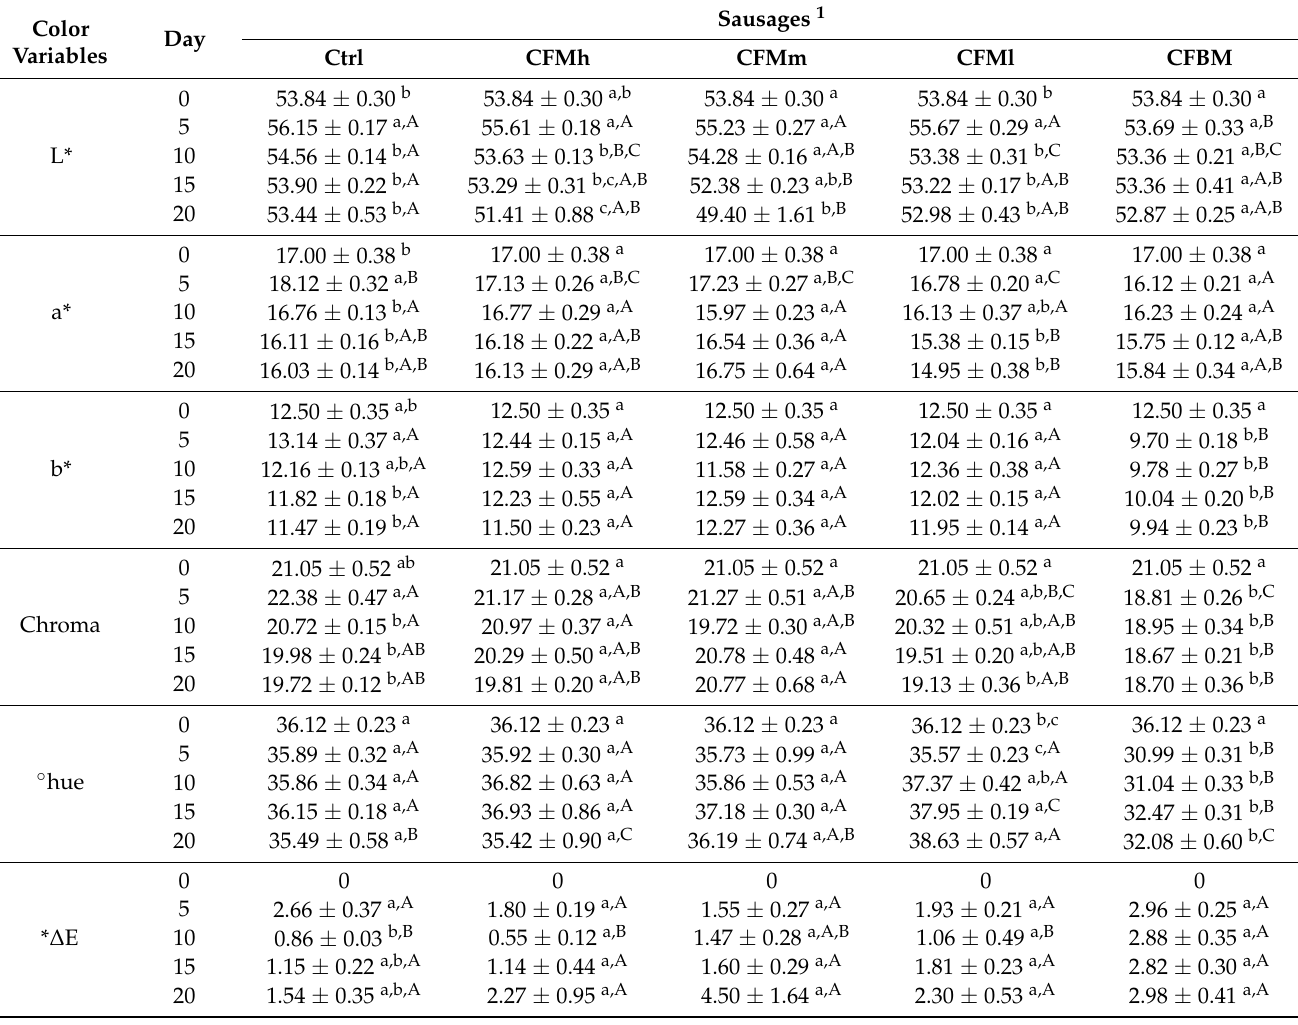
Table 3. Color values of uncovered sausages (Ctrl) and those covered with chitosan films during storage (0–20 days) at refrigeration conditions (4 ◦ C)